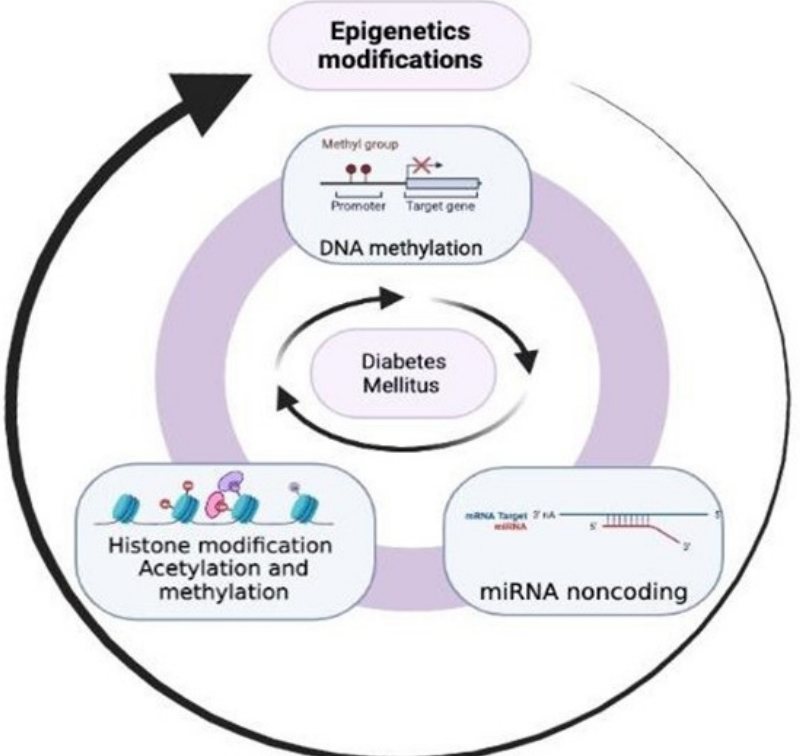
Figure 1. The role of epigenetics in the pathogenesis of type 2 diabetes. DNA methylation, histone modifications (acetylation/methylation), and noncoding RNA are present through different pathways of the pathophysiology of the disease.